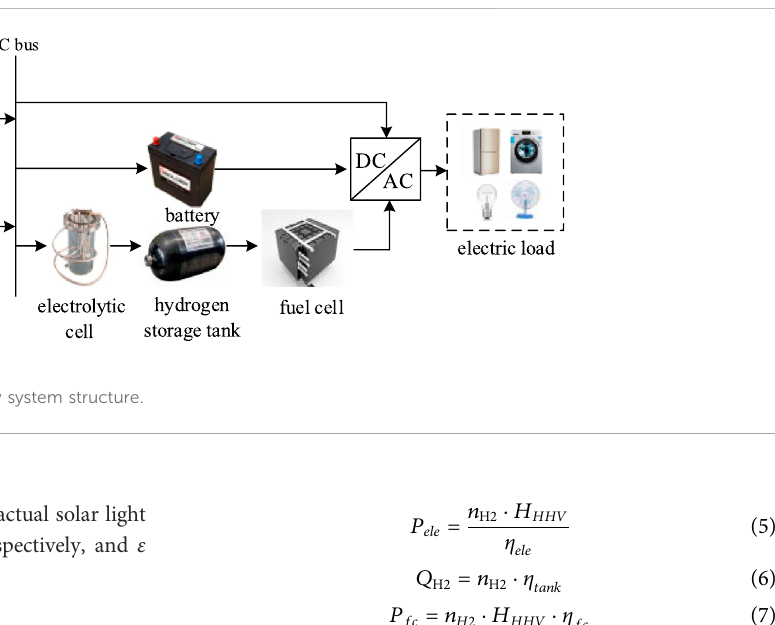
Wherein, P ele represents the input power of the electrolytic cell; n H2 represents the hydrogen production capacity of the system; H HHV represents the calori fi c value of hydrogen; η ele represents the hydrogen production ef fi ciency of the electrolytic cell, 70%; Q H2 represents the hydrogen storage capacity of the hydrogen storage tank; η tank represents the hydrogen storage ef fi ciency of the hydrogen storage tank, 95%; P fc represents the fuel cell output power; η fc represents the conversion ef fi ciency of the fuel cell, 65%.